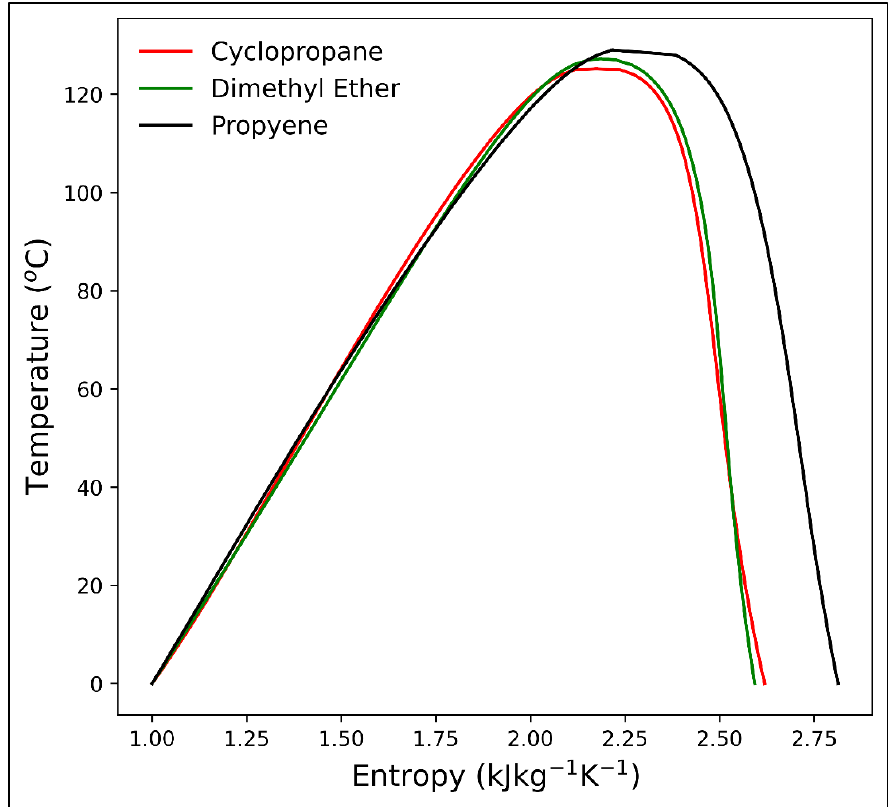
Figure 4. TS diagram of the selected working fluids (topmost: dry working fluids; middle: isentropic working fluids; and bottom: wet working fluids). Table 3. Thermal and environmental properties of the selected working fluids.